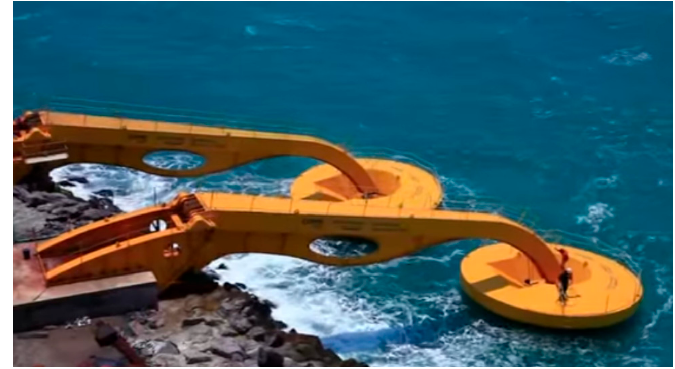
Figure 4. Seahorse power take off system, Brazil Pecem [25].